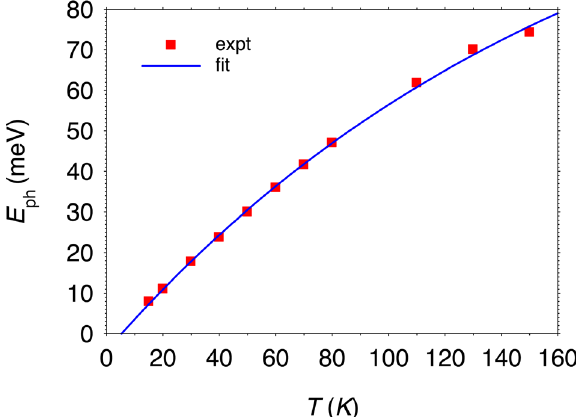
Fig. 6 Temperature dependence of effective phonon energy. Symbols, calculated values of E ph at temperature T . Solid line, fi t to E ph ( T ) = a [1 – exp ( − T / b )] + c , where a = 137 meV, b = 172 K, and c = − 4.17 meV.